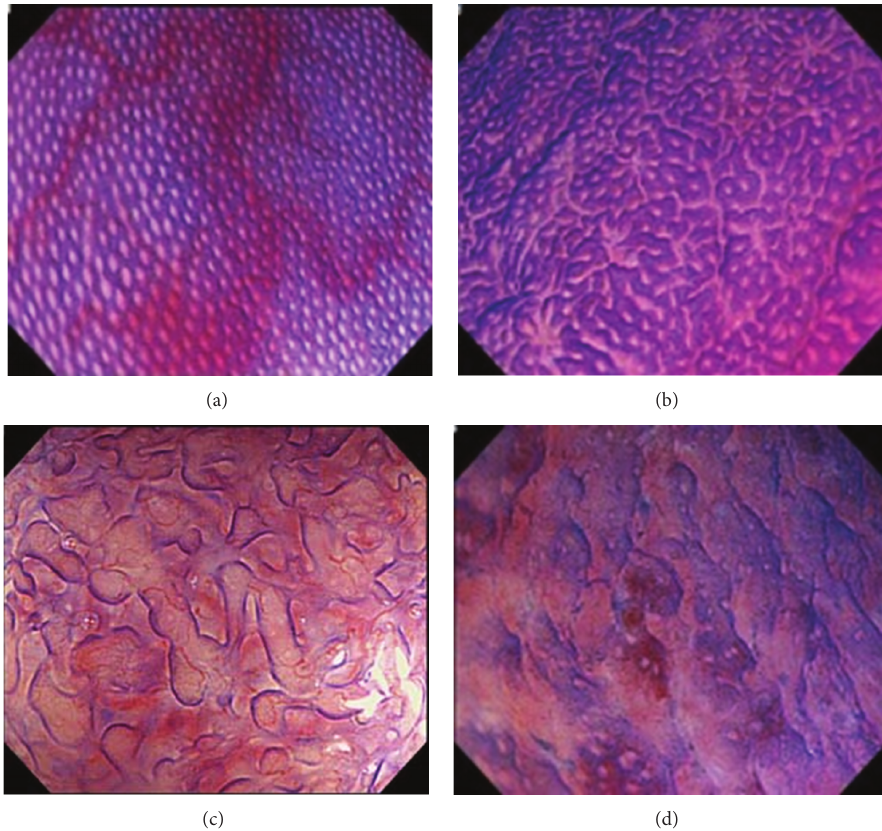
Figure 1: Magnifying endoscopic (ME) findings following crystal violet staining were classified into 4 grades as follows: ME-A, regular arrangement of normal-appearing round to oval pits (a); ME-B, irregular arrangement with/without enlarged spaces between the even pits (b);ME-C,irregularpitsinsizeandshapewithmoreirregulararrangementofpitscomparedtoME-B(c);andME-D,disruptedordisappeared pits